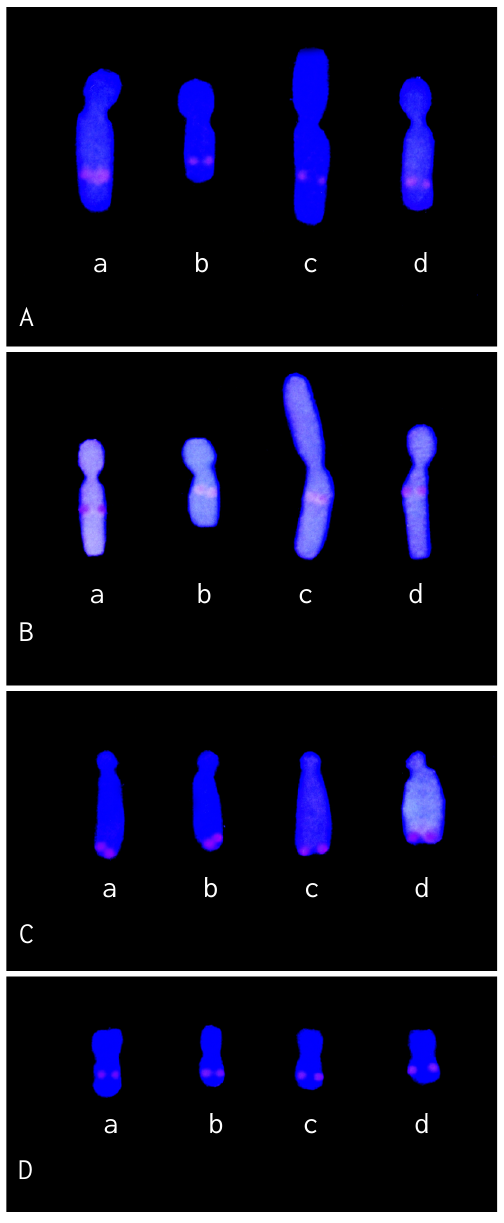
Figure 1 - Hybridization signals on (a) human, (b) chimpanzee, (c) gorilla and (d) orangutan chromosomes using the human chromosome-specific [A]